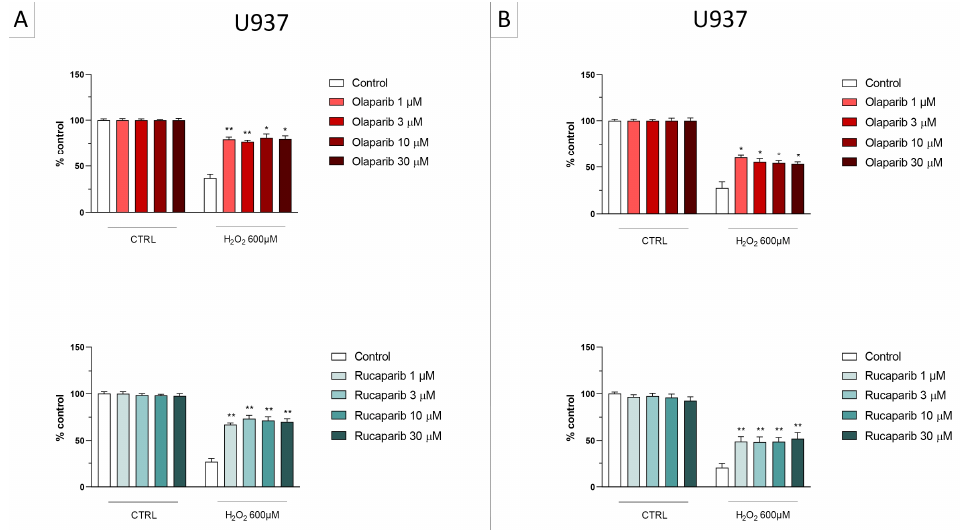
Figure 2. Effect of the clinical-stage PARP inhibitors olaparib or rucaparib on H 2 O 2 -induced suppression of cellular MTT-converting activity in U937 cells. Cells were treated for 2 h ( A ) or 24 h ( B ) with 600 µM H 2 O 2 ; the PARP inhibitors were applied at different concentrations (1, 3, 10, and 30 µM). * p < 0.05 and ** p < 0.01 indicate the beneficial effect of PARP inhibition to counteract the effect of oxidative stress. Data are shown as mean ± SEM of n = 5 independent experiments.